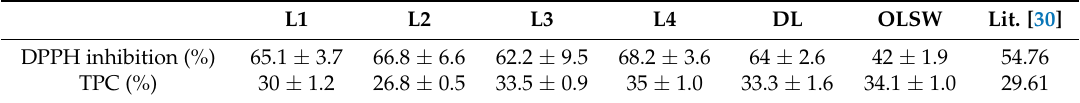
Table 5. The DPPH inhibitions and total phenolic content (TPC) values of kraft lignin fractions (L1 to L4) and two organosolv lignins obtained from beech (DL) and spruce/pine